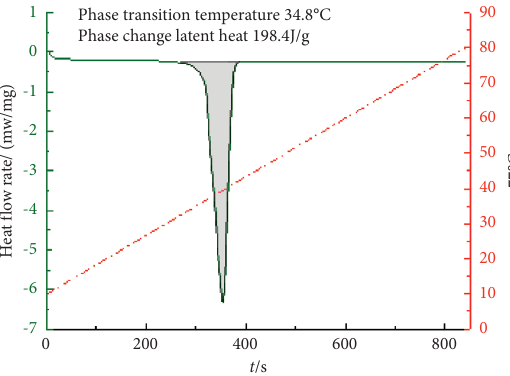
Figure 6: TD: MA is the DSC curve of TD-MA at 6.6:3.4.